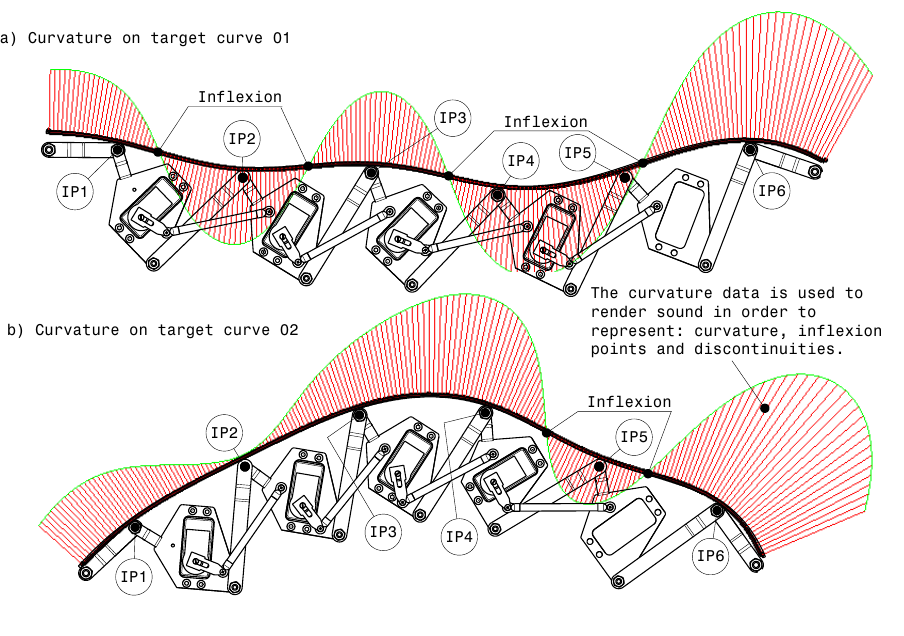
Figure 8. Examples of various